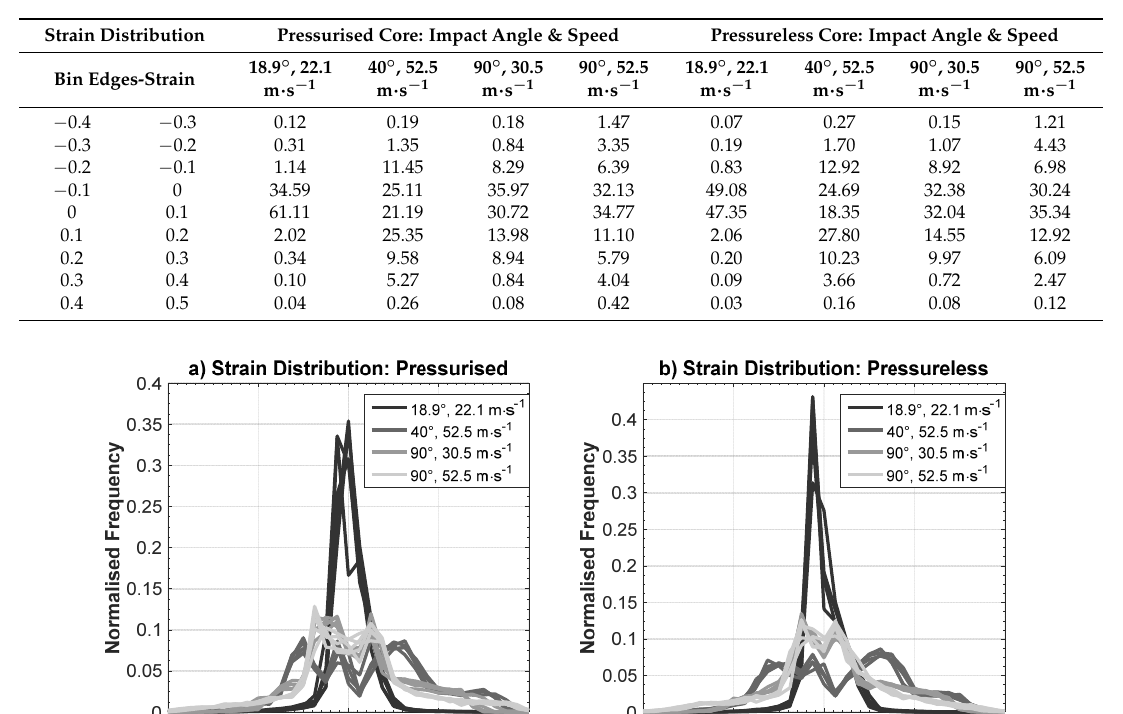
Table 5. Percentage distribution of strain during impact.